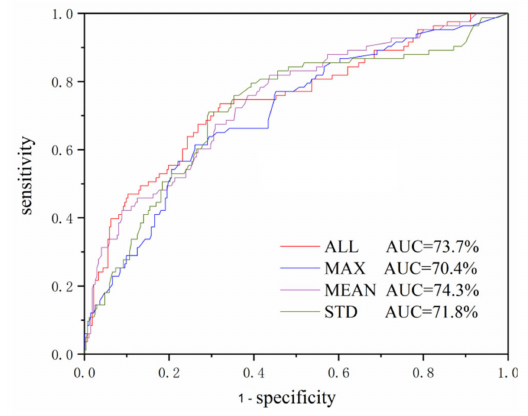
Figure 7. Di ff erence among the maximum and minimum susceptibility values mapped by the four model configurations.